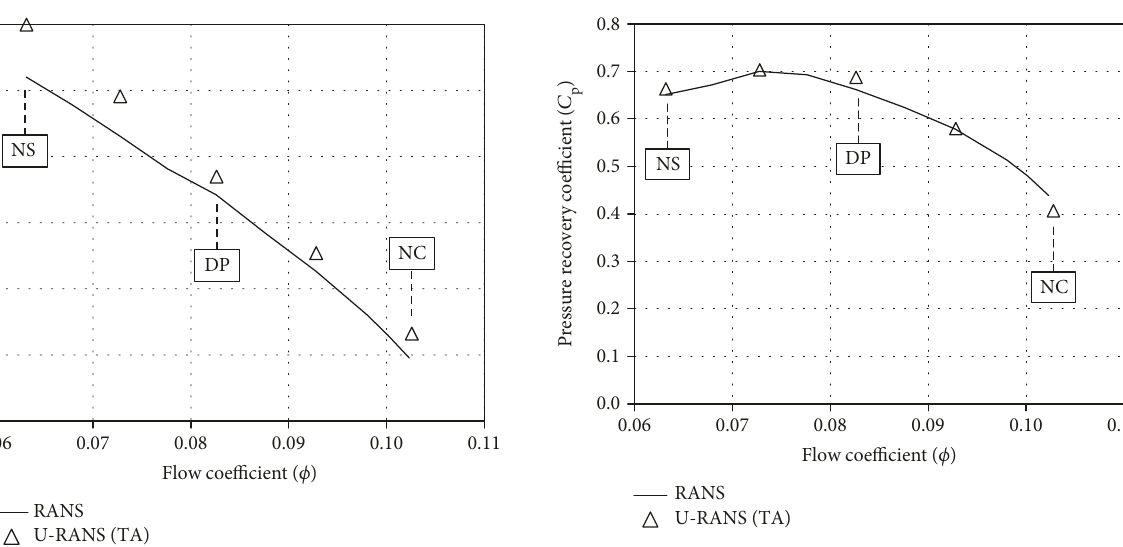
Figure 6: Total temperature rise in the compressor stage.